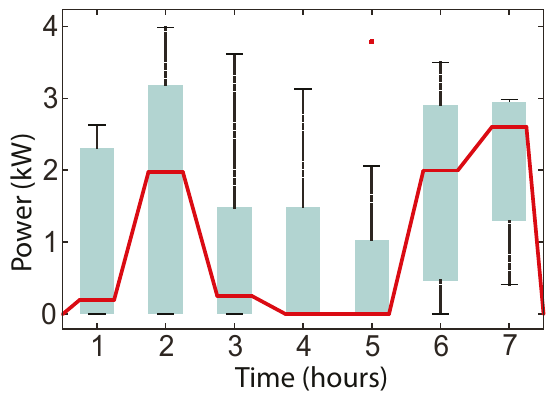
Fig. 7. Consumption pattern of variable load verses time i.e. an averaged for a